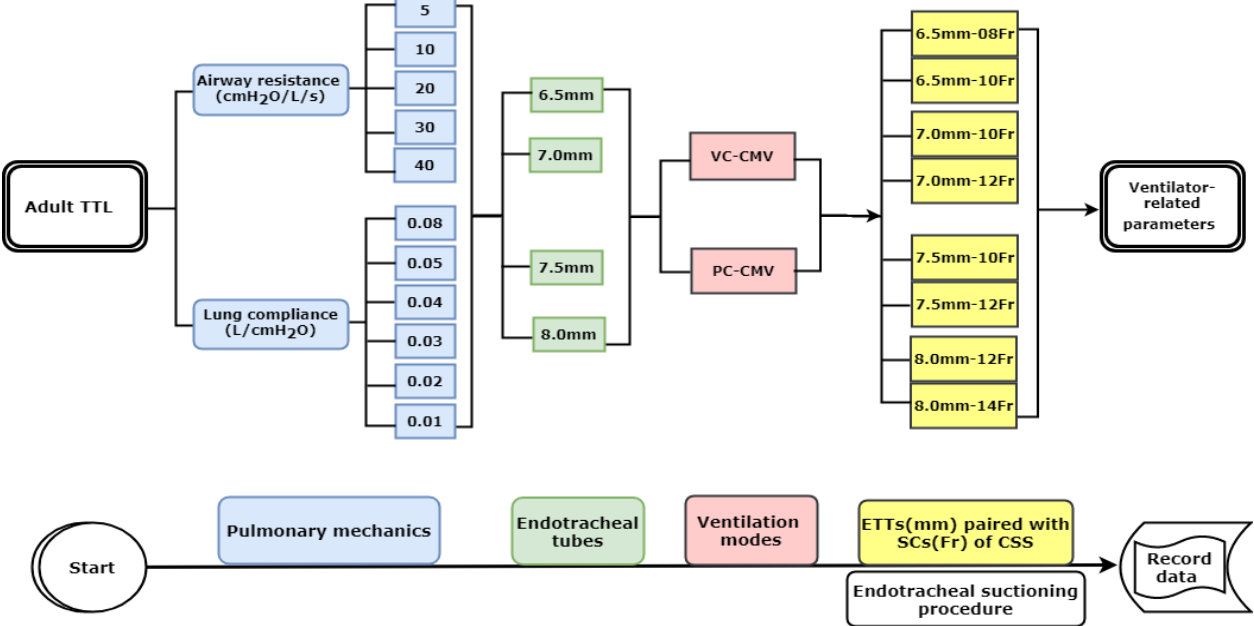
Figure 1. Experimental design and process. TTL: adult training lung; VC-CMV: volume control continuous mandatory ventilation; PC-CMV: pressure control continuous mandatory ventilation.